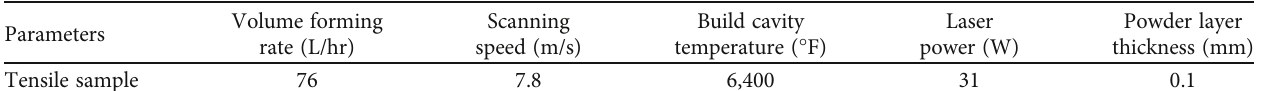
T ABLE 1: 3D printing